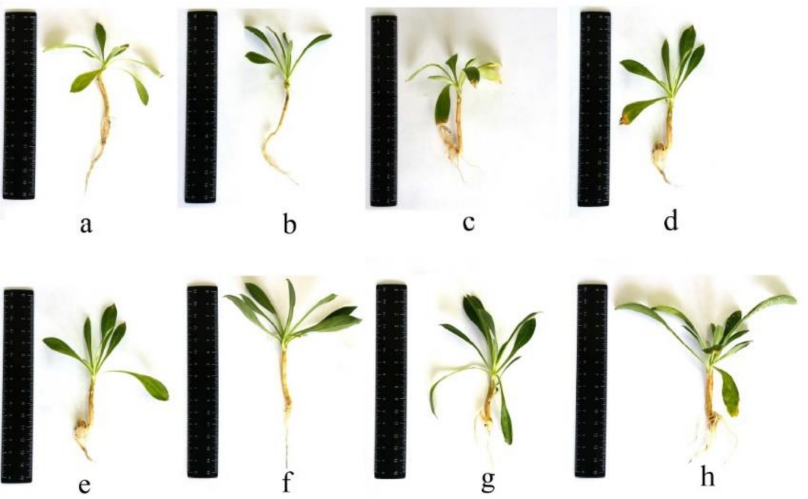
Figure 4. The appearance of S. repens seedlings (age 2 months) after 1 month of phytohormones and elicitors treatment. The letters indicate phytohormones and elicitors used (100 mg/L): ( a )—control 1; ( b )—control 2; ( c )—indole-3-butyric acid; ( d )—4-chlorophenylacetic acid; ( e )—epibrassinolide; ( f )—arachidonic acid; ( g )—gibberellic acids potassium salt; ( h )—ethyl